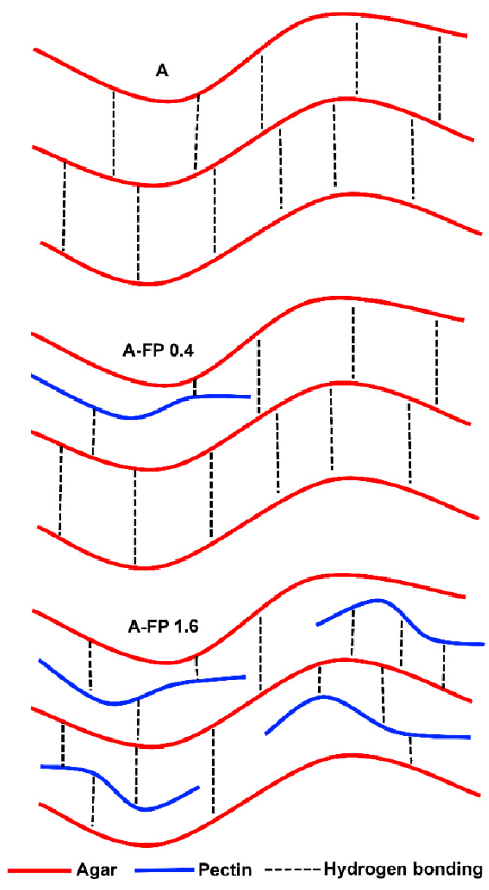
Figure 8. Schematic illustration of a proposed gel network in A and A-FP gels.